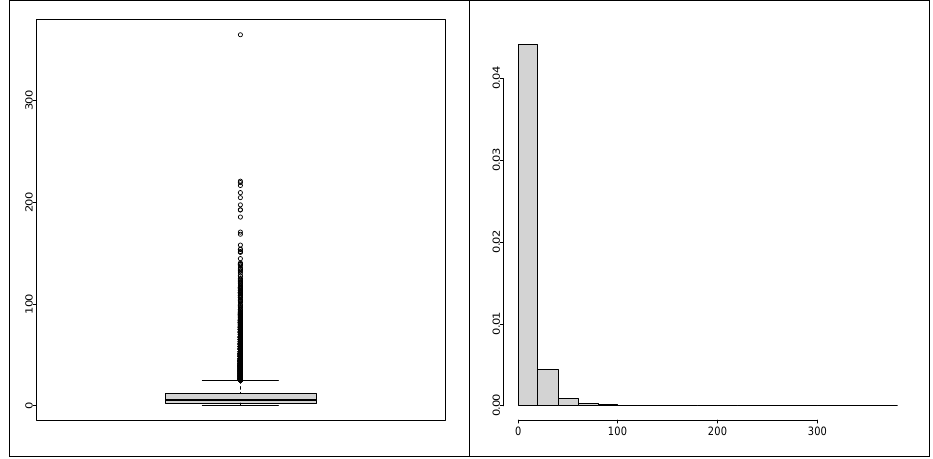
Figure 2. Box-plot (left panel) and histogram (right panel) of length of